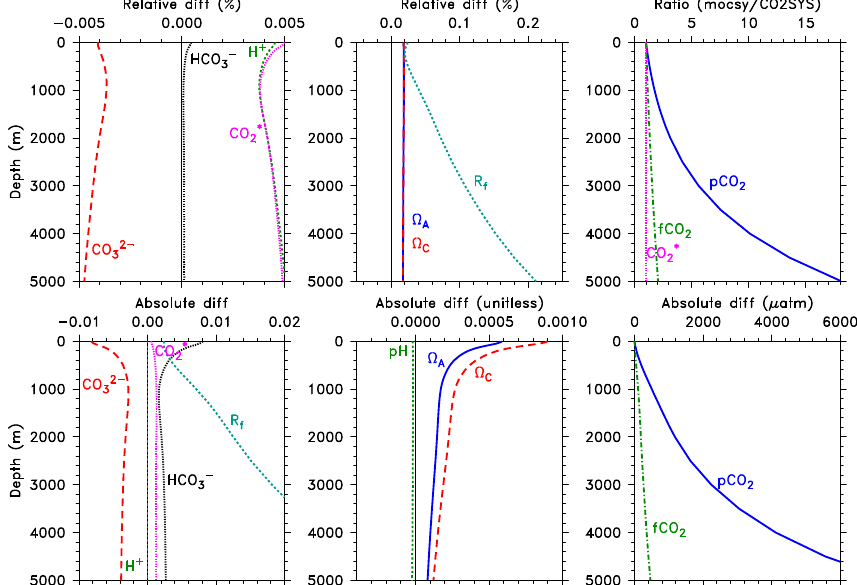
Figure 5. Differences in global-mean profiles between mocsy and CO2SYS for computed variables, as in Fig. 4. The large differences in f CO 2 and p CO 2 (top right) are shown as ratios